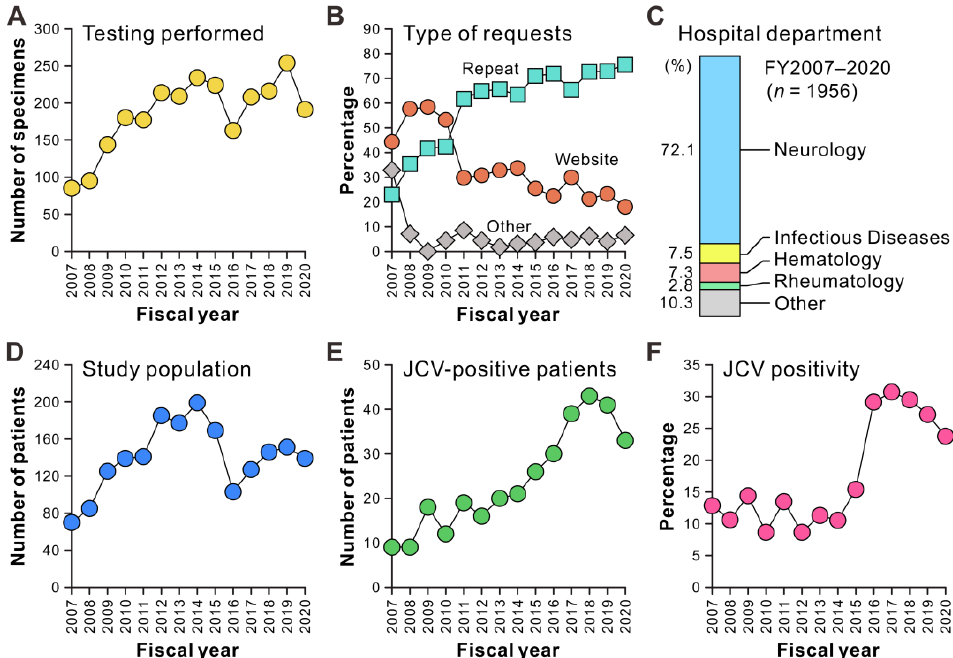
Figure 1. Track record of laboratory surveillance of PML based on PCR testing for JCV in CSF samples. ( A ) Number of CSF-JCV testing performed per year during the 4-year start-up period (FY2007–2010) and the study period (FY2011–2020). The result includes follow-up JCV testing after PML diagnosis. ( B ) Types of requests for CSF-JCV testing from medical departments to the NIID. The requests for CSF-JCV testing for new suspected PML cases in each fiscal year, excluding follow-up testing after PML diagnosis, were classified into three categories: direct contact through the websites, repeat requests from departments that had previously performed the test, and others. ( C ) Hospital departments of physicians who submitted requests for CSF-JCV testing to the NIID. ( D ) Number of new patients with suspected PML tested for CSF-JCV in each fiscal year. ( E ) Number of new patients with JCV-positive CSF in each fiscal year. ( F ) Proportion of patients with JCV-positive CSF among newly tested individuals in each fiscal year.